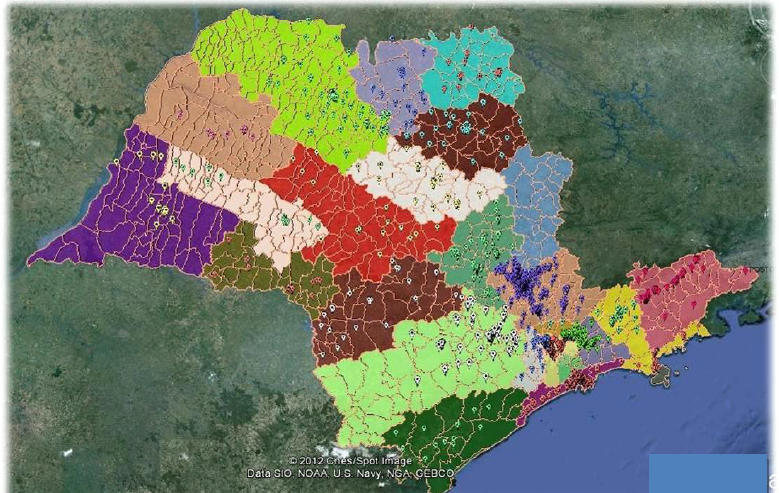
Figure 8. Map of contaminated areas in SP state, 2011.